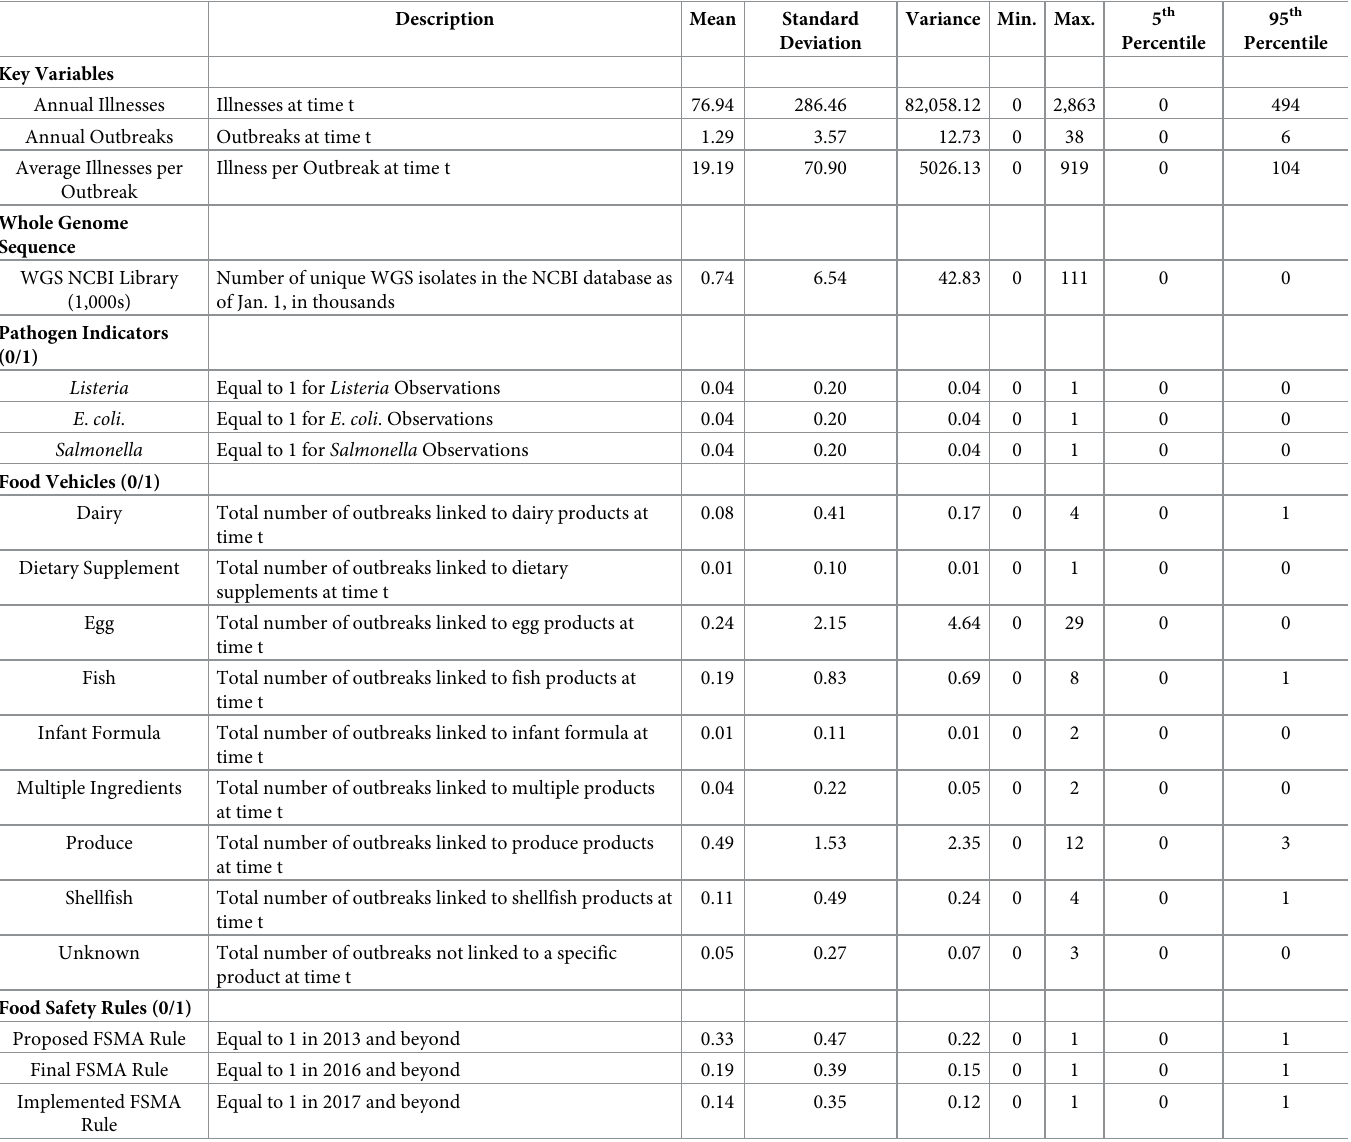
Table 1. Summary